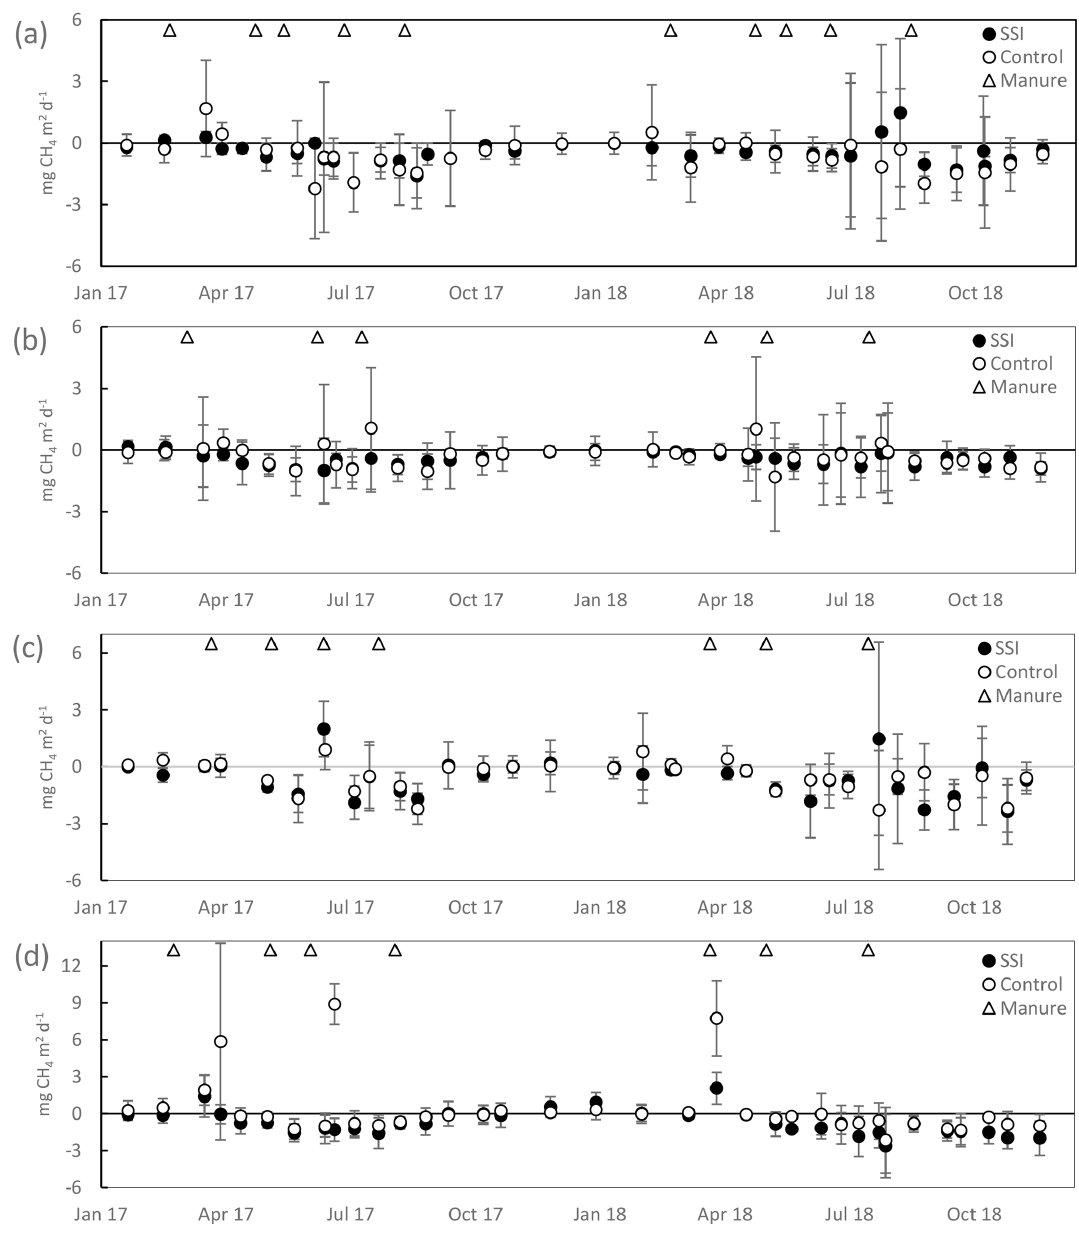
Figure C1. CH 4 exchange throughout 2017 and 2018 in mgCH 4 m − 2 d − 1